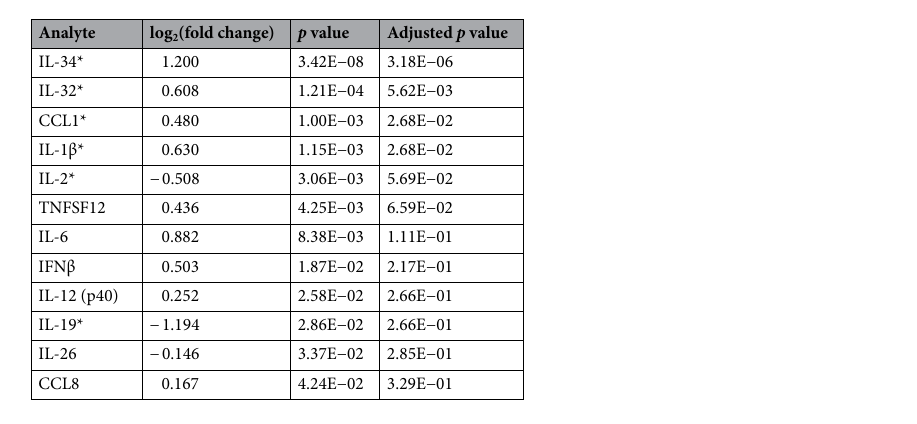
nodes including 10 additional relevant proteins, and 120 edges. Most protein interactions are related to IL-6, IL-10, IL-1β, IL-2, and STAT3, while information is limited regarding the interaction profile of TNSF12, IL-32, CCL1, and CCL8. The interaction between IL-34 and CSF1R provided the highest combined score, which is STRING’s confidence score calculated from all the contributing evidence. The interaction of IL-19 with STAT3 or IL-26 also provided a high or moderate combined score, respectively. To get further insight into the signaling pathway that mediates the relapse, we further performed pathway analysis using Kyoto Encyclopedia of Genes and Genomes (KEGG) database. We found that these genes were involved in infectious disease responses such as Chagas disease, measles, influenza A, and tuberculosis as well as immune-mediated disorders such as inflam- matory bowel disease, graft-versus-host disease, and type I diabetes (Fig. 5b). A similar immune pathway might be at work in rheumatoid arthritis. Univariate receiver operating characteristic curve (ROC) analysis. Univariate ROC curve analysis was performed to evaluate the diagnostic power of best performing cytokines for prediction of future relapse in patients in remission. The cytokine concentration data, which are log-transformed but without autoscaling, were used for the analysis. When the value of area under the curve (AUC) was > 0.7, five cytokines, IL-34, IL-32, CCL1, IL-1β, and CCL3 were identified as potential biomarkers. The AUC was 0.813 for IL-34, 0.743 for IL-32, 0.737 for CCL1, 0.714 for IL-1β, and 0.711 for CCL3 (Fig. 6 and Table 3). The top four of the AUC-selected 5 cytokines were common to those selected in sPLS-DA (Fig. 3) and p -value (Fig. 4) methods. In both, autoscaled